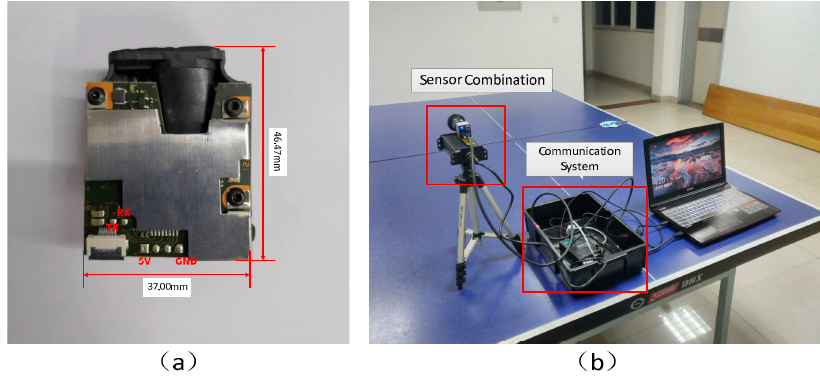
Figure 2. The mono-LRF system assembled via integration of the monocular vision and the LRF. ( a ) Industrial module for 1D laser range finder (LRF); ( b ) The mono-LRF measurement system we built include PC, communication system and sensor combination.